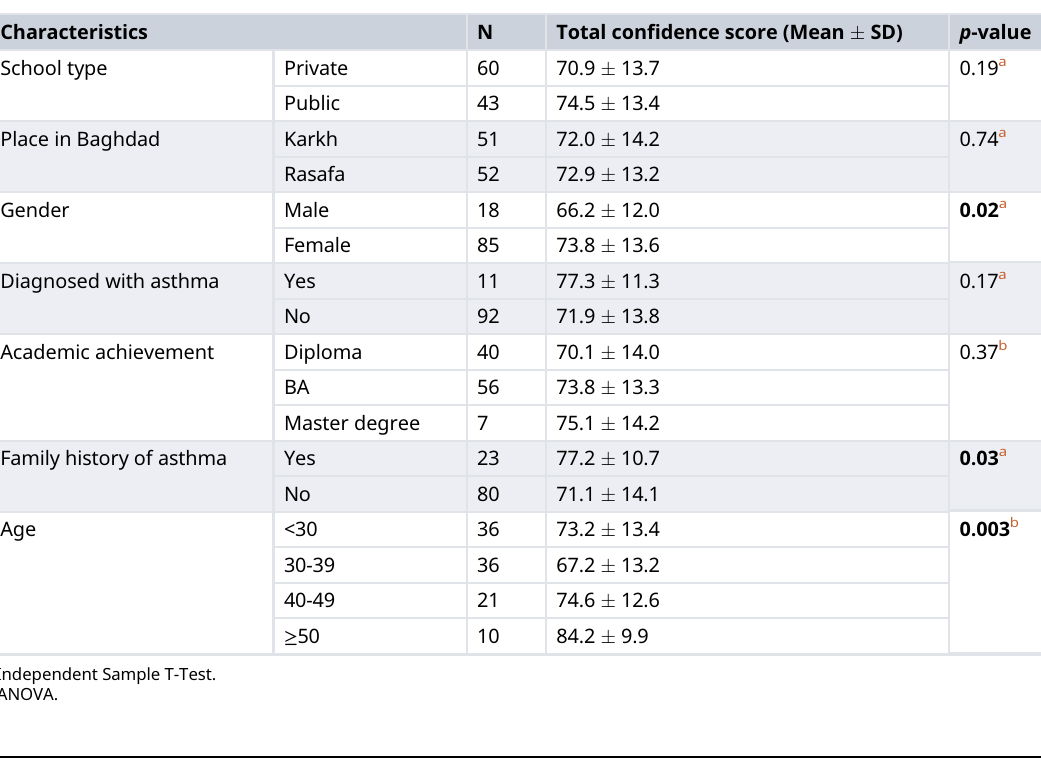
Table 5. Association between the total knowledge score and sociodemographic characteristics of primary school teachers.